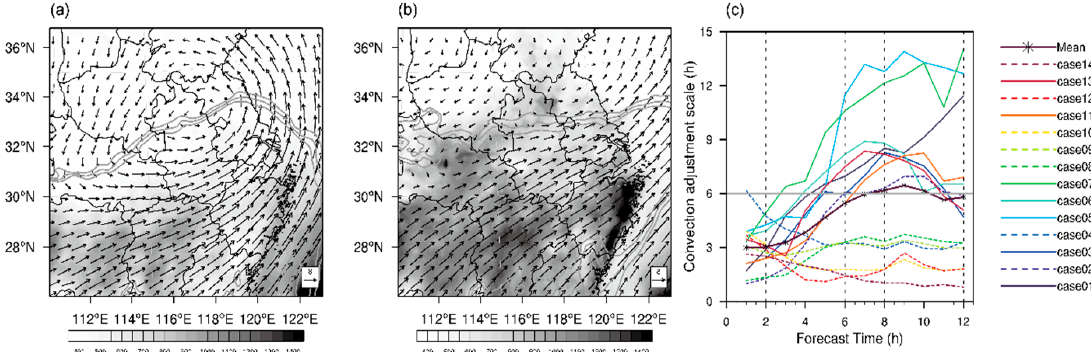
Figure 2. Ensemble-mean case-averaged 850 hPa wind vector (m / s), equivalent potential temperature (344–348 K, 2 K interval, indicative of the location of the Meiyu front) and convective available potential energy (white to black scale, J / Kg) for the ( a ) strong forcing (SF) and ( b ) weak forcing (WF) cases. ( c ) The convective adjustment timescale ( τ c ) averaged over all areas with a rainfall higher than 0.5 mm / h as a function of forecast time (in hours) for 14 heavy rainfall events.